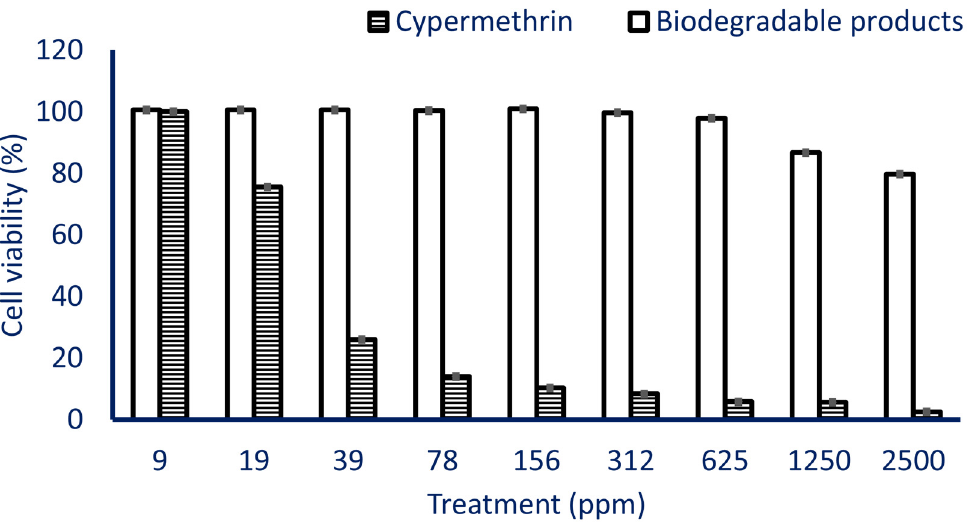
Figure 9. In vitro cytotoxic efficacy of cypermethrin before and after bacterial degradation on Vero cell line viability.